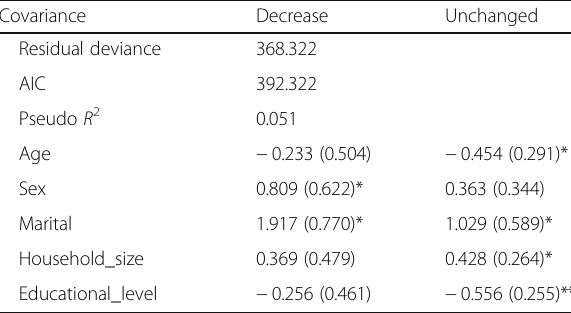
Table 3 Results of multinomial regression of G. kola farmer ’